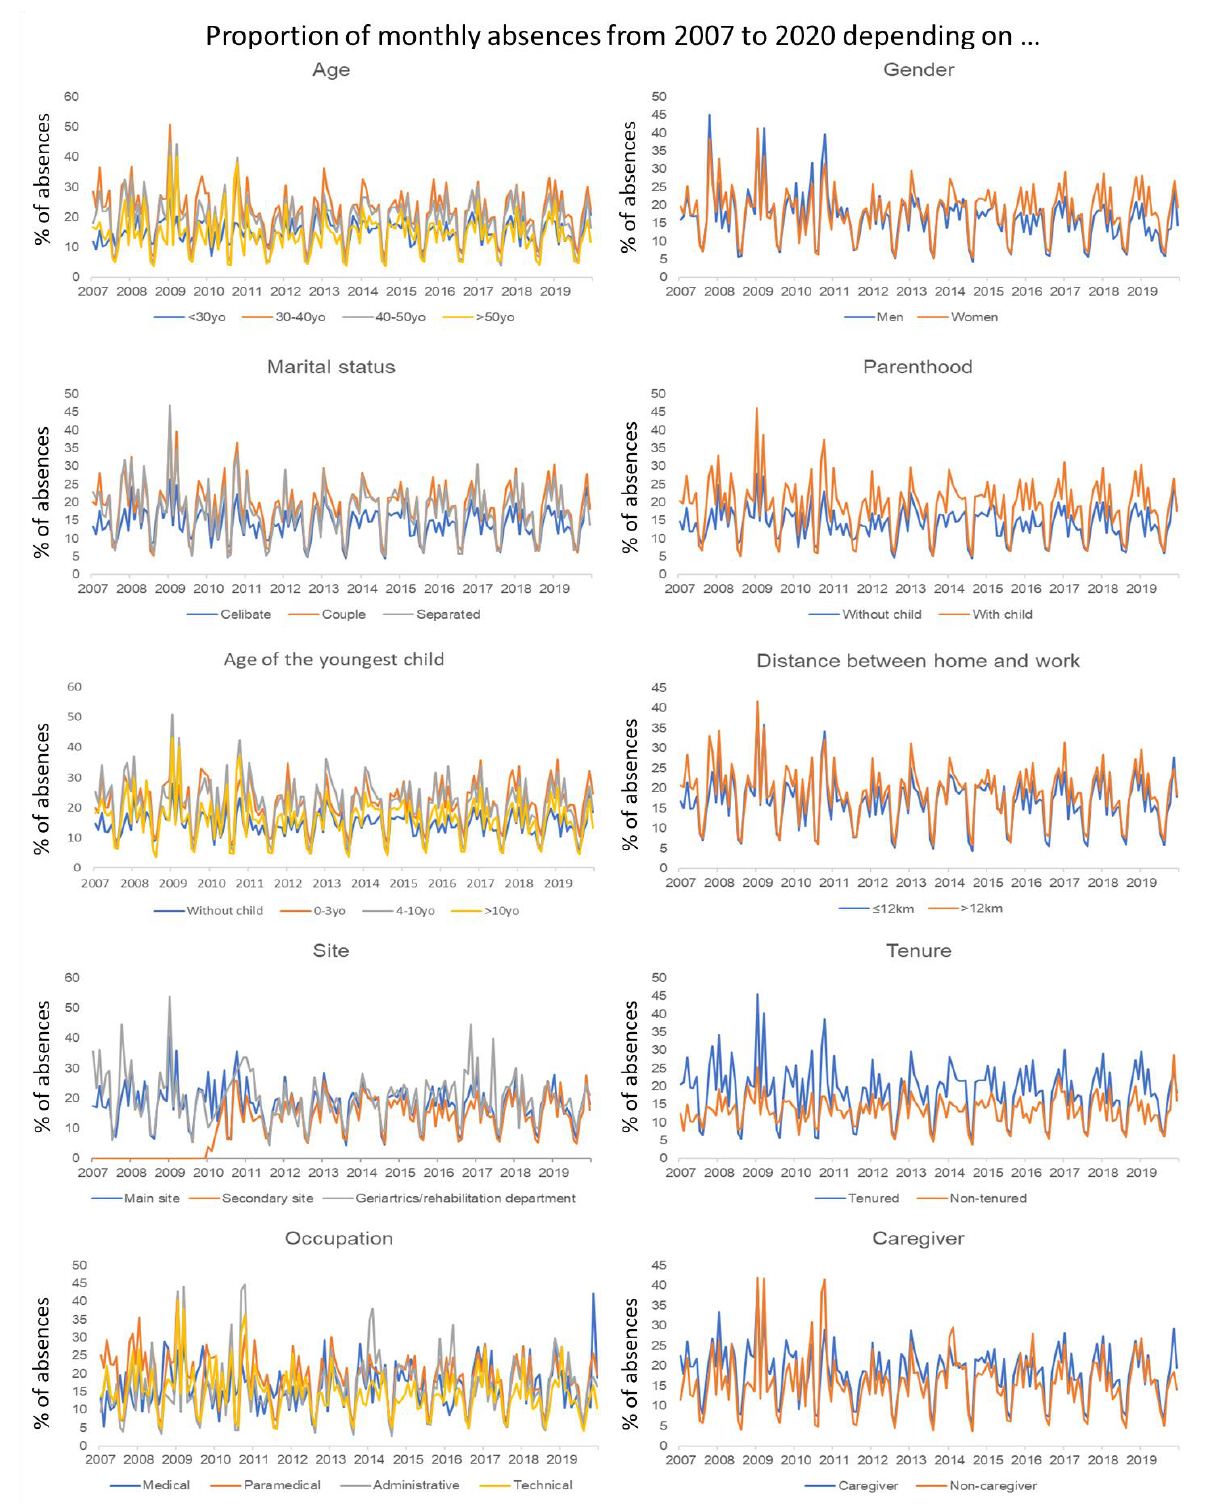
Figure 2. Proportion of monthly absences by sociodemographic and professional